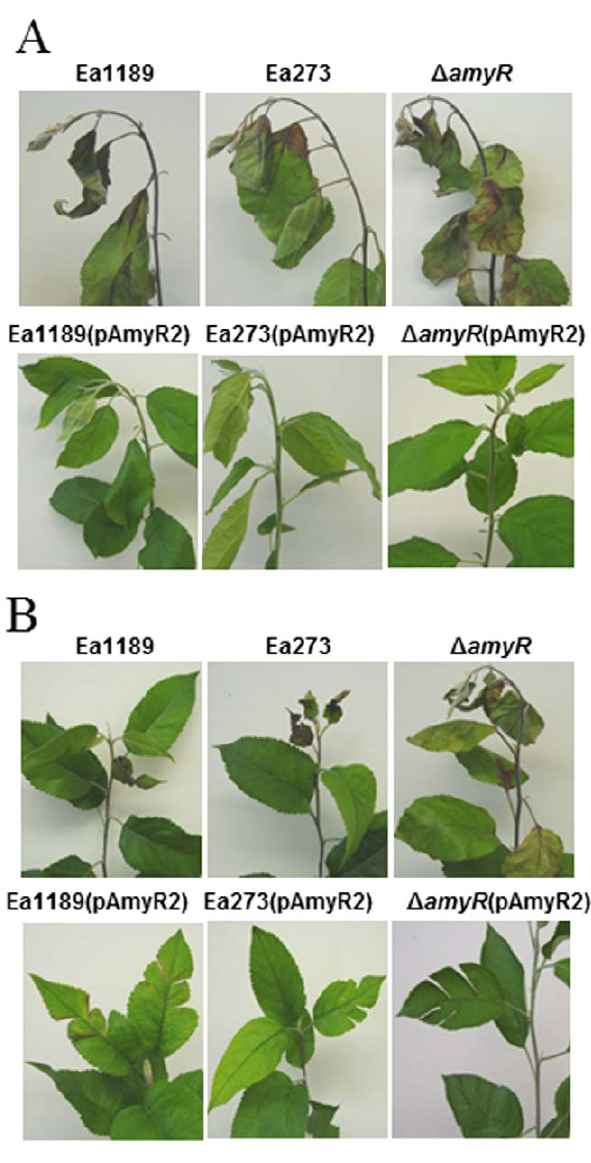
Figure 3. Virulence assays on apple shoots. A . Symptoms caused by Erwinia amylovora wild type (WT), amyR mutant, complementation strain and WT containing pAmyR2 plasmid on shoots of apple cv. Gala at 8 dpi. Virulence assays were performed using young annual shoots by pricking the tip with a needle, and pipetting 5 m l of pathogen suspension (OD 600 =0.1) onto the wounded tissue. The experiment was performed at least three times with similar results. B . Symptoms caused by WT and various strains on leaves of apple cv. Red Delicious at 8 dpi. Young leaves of Red Delicious plants were inoculated with scissors dipped in a bacterial suspension (OD 600 = 0.1). dpi: days post inoculation. (Table 1), indicating the validity of mutant and amyR over- expression strains.